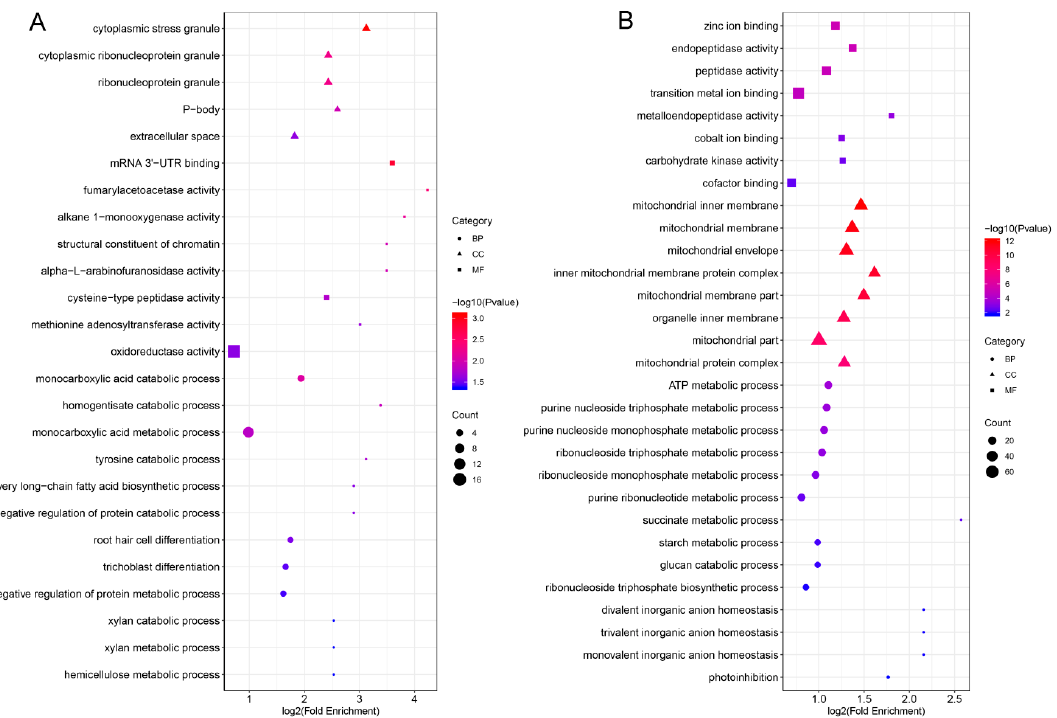
Figure 7. GO (gene ontology) enrichment of DEPs in three categories (BP, biological process; CC, cellular component; MF, molecular function). ( A ) GO enrichment of the comparison group P2 vs. Y2. ( B ) GO enrichment of the comparison group P4 vs. Y4.